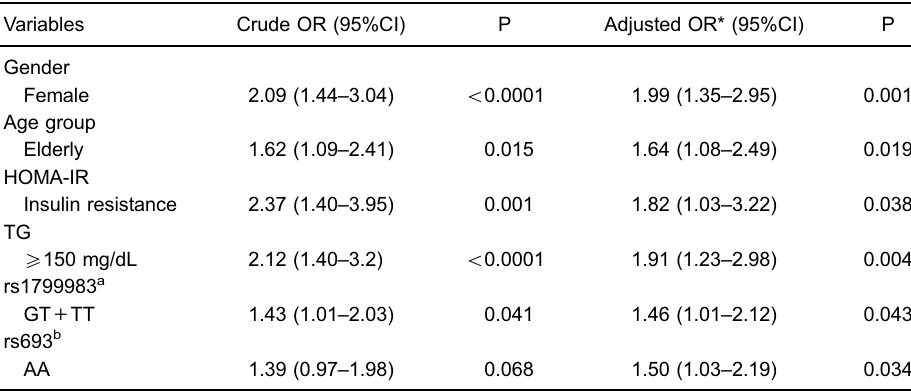
Table 5. Binary logistic regression analysis of risk factors of cardiovascular disease associated with high levels of chemerin in the study population. Variables